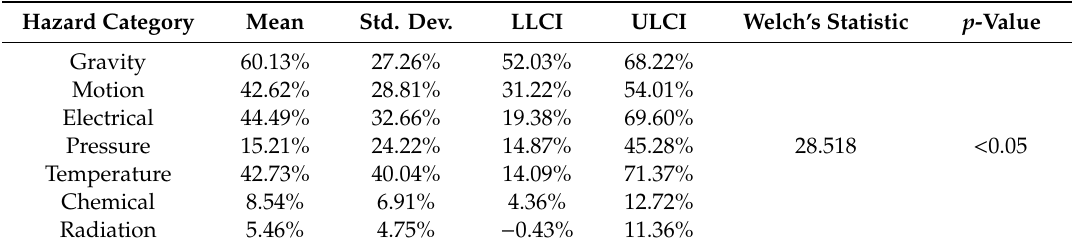
Table 2. Demonstrated proficiency levels—descriptive and inferential statistics